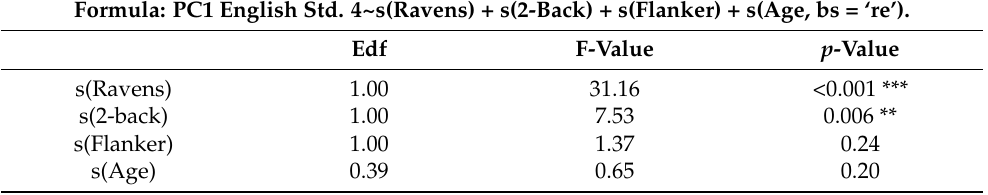
Table A2. Output of the generalized additive model for the English literacy in Std. 4.